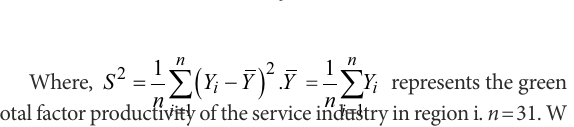
represents the green total factor productivity of the service industry in region i. n = 31. W is the spatial weight matrix, and the value range of I is - 1 ≤ I ≤